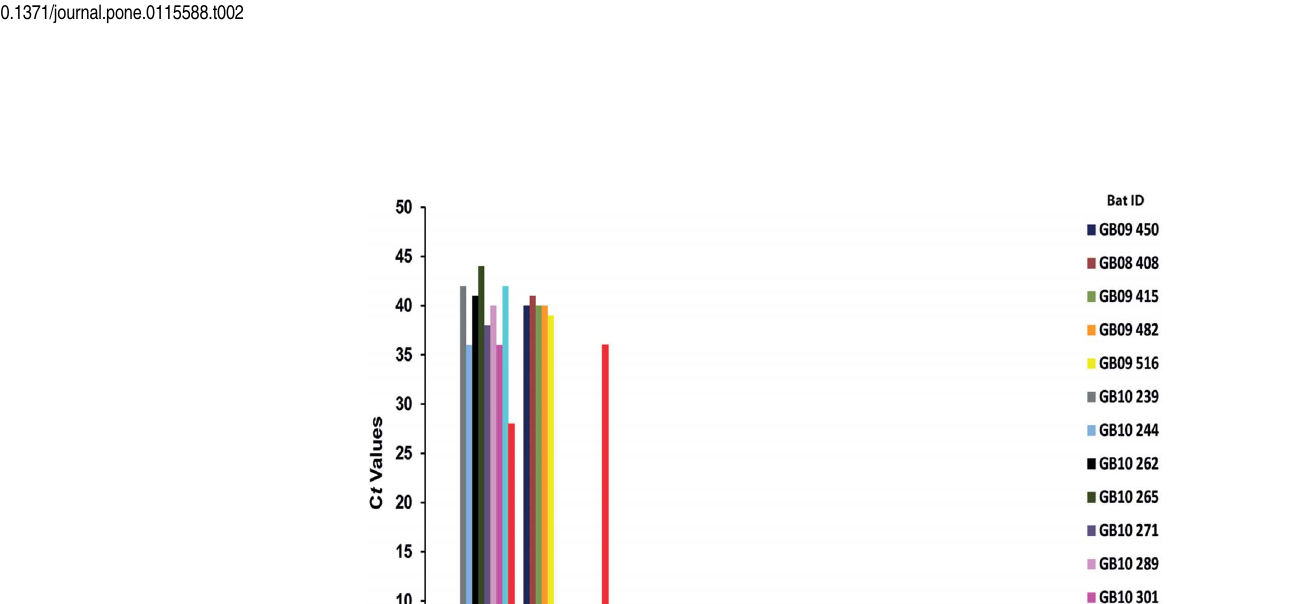
Undet. Undet. Undet. Undet. Undet. Undet. 42 Undet. Undet. Undet. Undet. Undet. Undet.